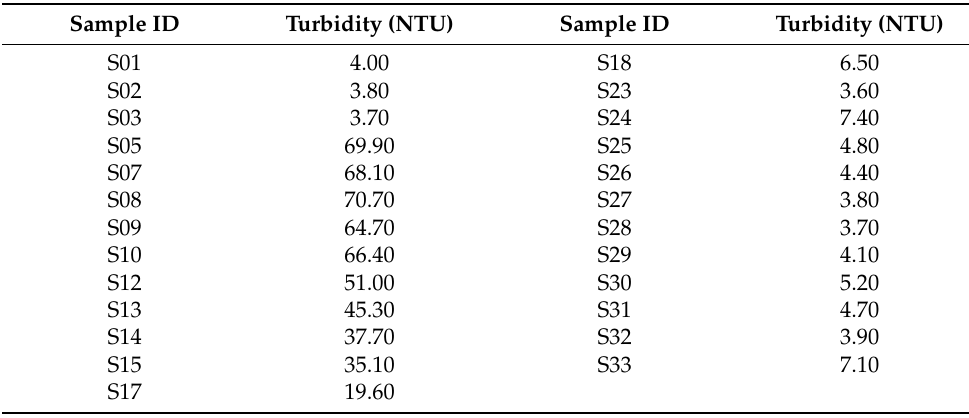
Table 5. Test data for 15 August 2019 image